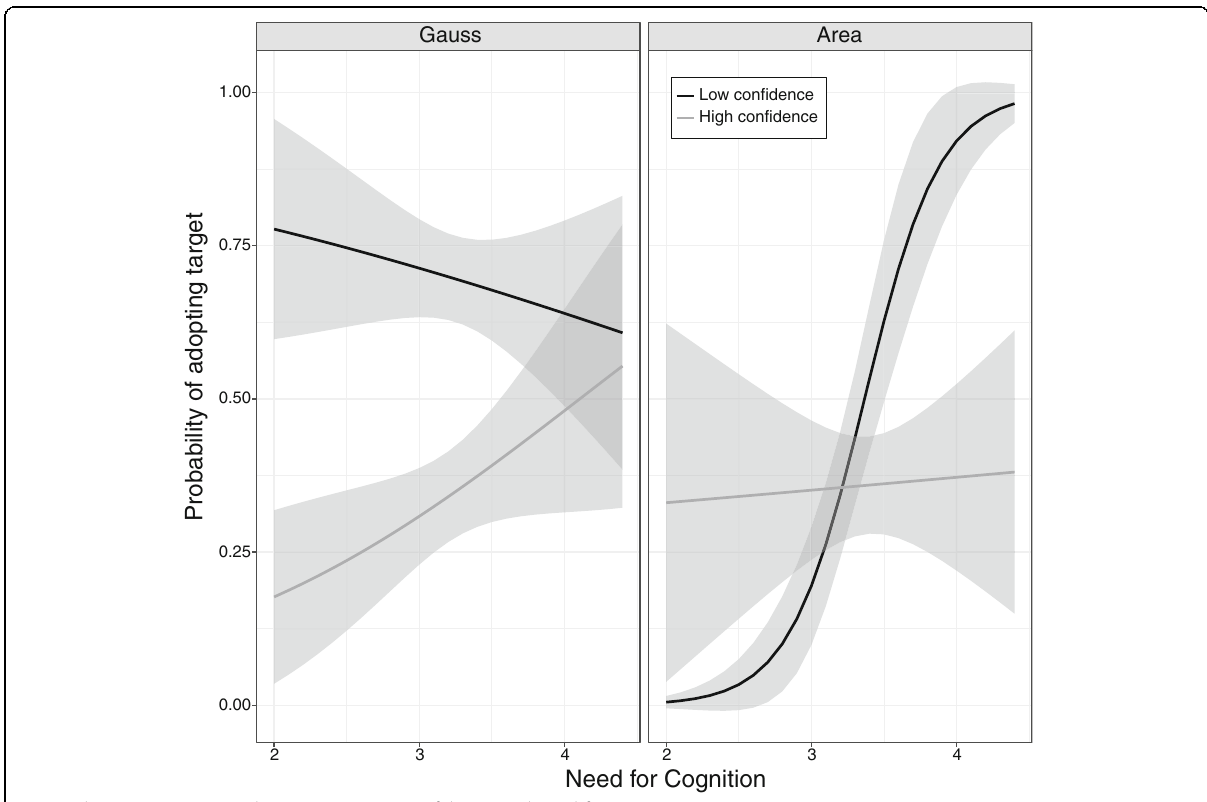
Fig. 8 Three-way interaction between strategy, confidence, and need for